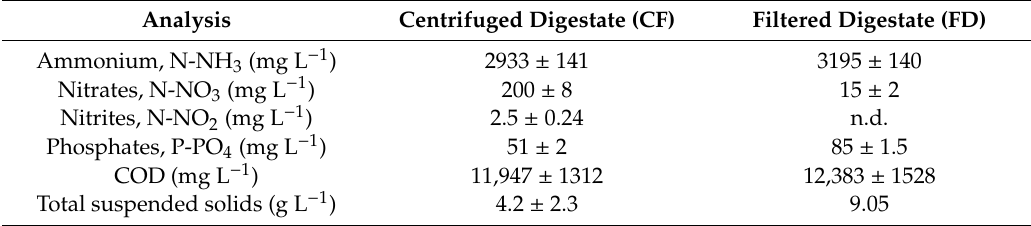
Table 1. Composition of the digestate samples used in this